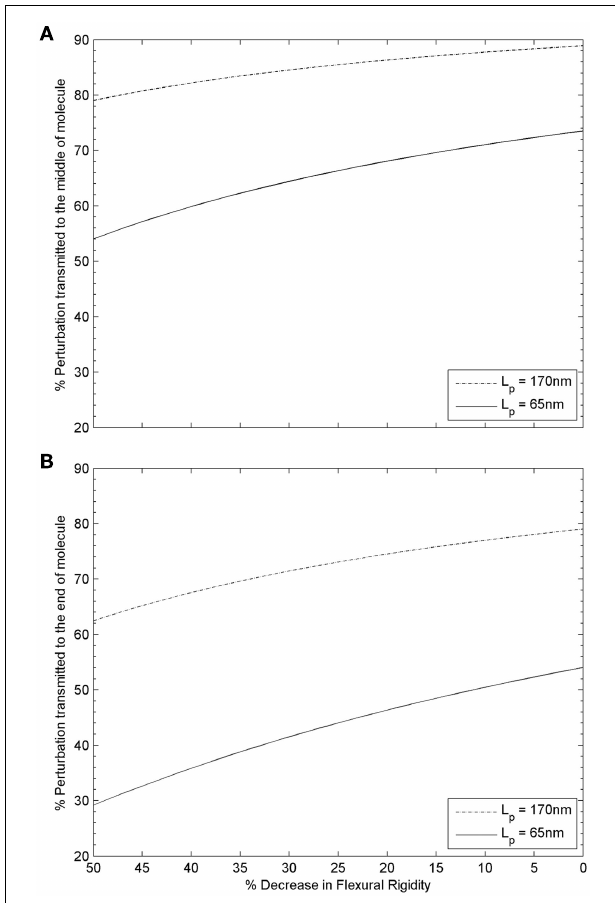
FIGURE 5 |Variation of structural perturbation signal transmitted from (A) the ends to the middle of a tropomyosin molecule, or (B) from the Ca 2 + bound end to the Ca 2 + free end of a tropomyosin molecule as a function of the flexural rigidity of tropomyosin. (A) When the two ends of aTm molecule are either both Ca 2 + free, or both have Ca 2 + bound, the structural change in the middle of the molecule, relative to that at either end, is greater for a rigidTm ( L p > L c , dotted-dash line) than for a semi-flexibleTm ( L p ∼ L c , solid line) as expected.The effect of a reduction in flexural rigidity as is hypothesized to be found in some cases of FHC (compare left side of graph with initial value at right) is substantially more significant for the initially semi-flexibleTm ( L p ∼ L c , solid line) than the rigid Tm ( L p > L c , dotted-dash line); for the case of semi-flexibleTm ( L p ∼ L c , solid line), an additional ∼ 25% drop is predicted when the initial rigidity is halved. (B) Thin filaments are not fully saturated by Ca 2 + during systolic activation of cardiac muscle.When only one end of aTm molecule has Ca 2 + bound, the structural change at the Ca 2 + free end relative to that at the end with Ca 2 + bound is greater for a rigidTm ( L p > L c , dotted-dash line) than for a semi-flexibleTm ( L p ∼ L c , solid line) as expected. As in panel A, the effect of a reduction in flexural rigidity as is hypothesized to be found in some cases of FHC (compare left side of graph with initial value at right) is much more significant for the initially semi-flexibleTm ( L p ∼ L c , solid line) than the rigidTm ( L p > L c , dotted-dash line). For the case of a rigidTm ( L p > L c , dotted-dash line), 63% of the signal is transmitted when the initial rigidity is halved. In comparison, only 29% of the signal is transmitted in the case of a semi-flexibleTm ( L p ∼ L c , solid